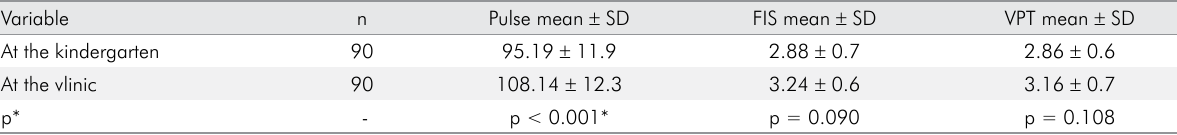
Table 2. The entire sample population’s pulse rates, facial images scale (FIS) scores, Venham picture test (VPT) scores at the kindergarten before treatment and at the clinic after